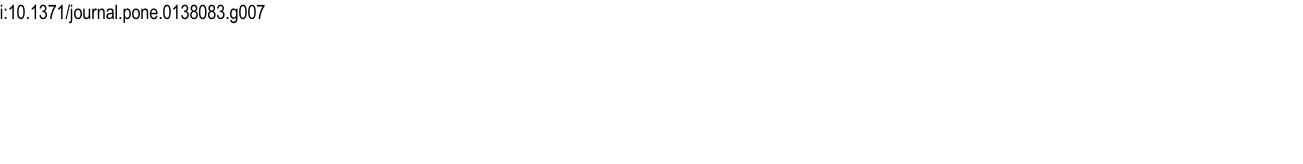
PLOS ONE | DOI:10.1371/journal.pone.0138083 September 15,